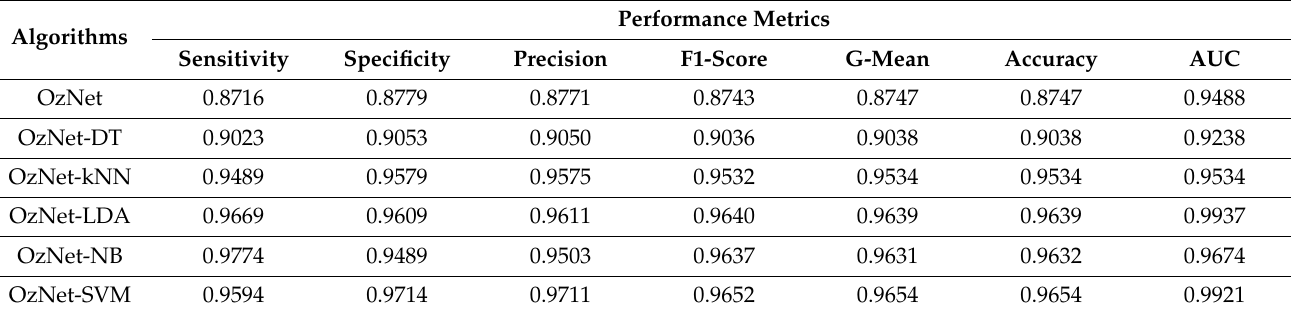
Table 4. Performance metrics of algorithms on Brain Stroke CT